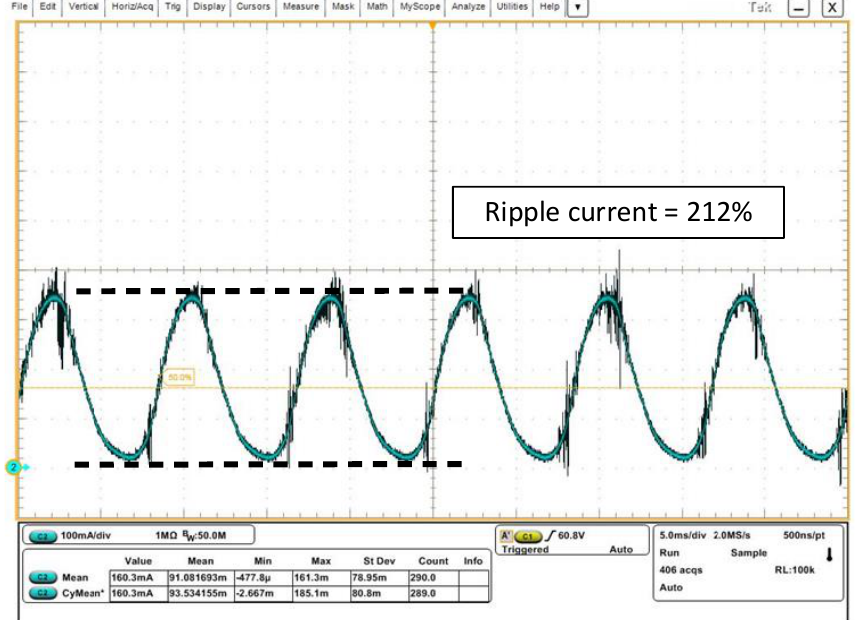
Figure 18. Instantaneous voltage in experimental tests of the LED lamp. 10 V/div, average voltage in the LED 60.5 V.